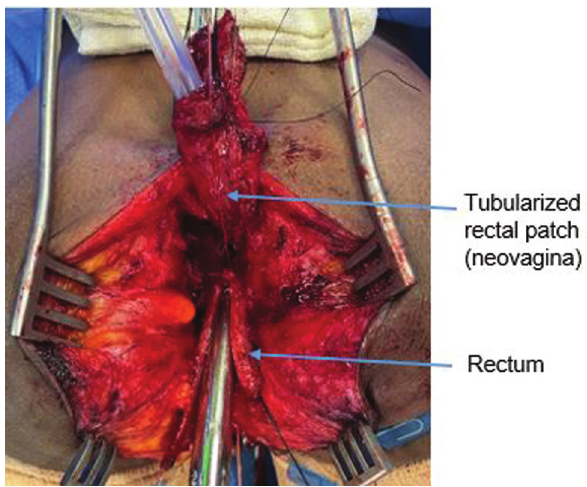
Fig. 4 The neovagina is reconstructed using the rectal patch, shown here being tubularized over a Hegar dilator. The patch was sutured to the wall of the vagina circumferentially. A 24-French Foley catheter, used for calibration of the rectoplasty, is seen in the